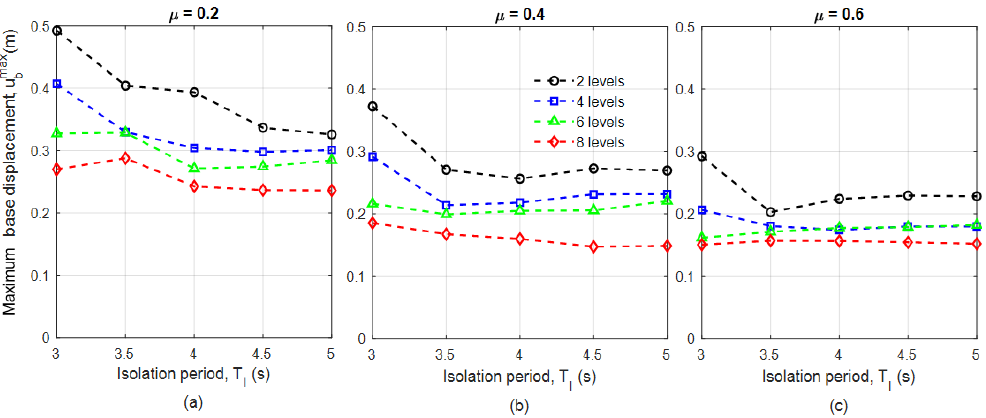
Figure 13. Maximum displacement of the isolation level. ( a ) μ = 0.2, ( b ) μ = 0.4 y and ( c ) μ = 0.6.